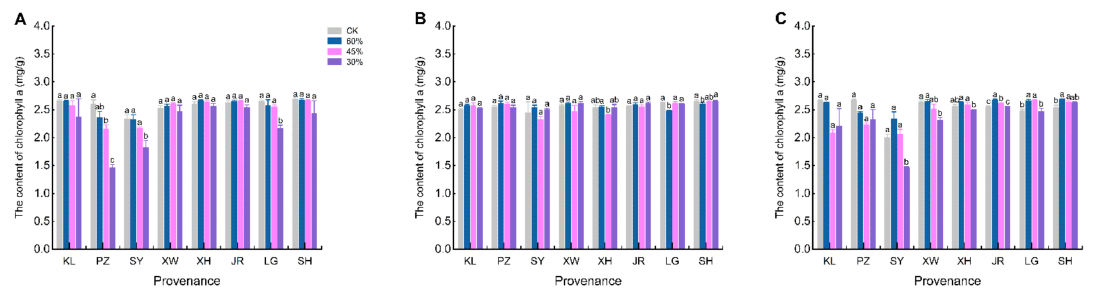
Figure A3. The chlorophyll a content of Melia azedarach among the different provenances: ( A ): early stage, ( B ): middle stage, and ( C ): late stage. Note: The error line in the figure is the mean ± standard error, and different lowercase letters in the same treatment indicate significant differences at the 0.05